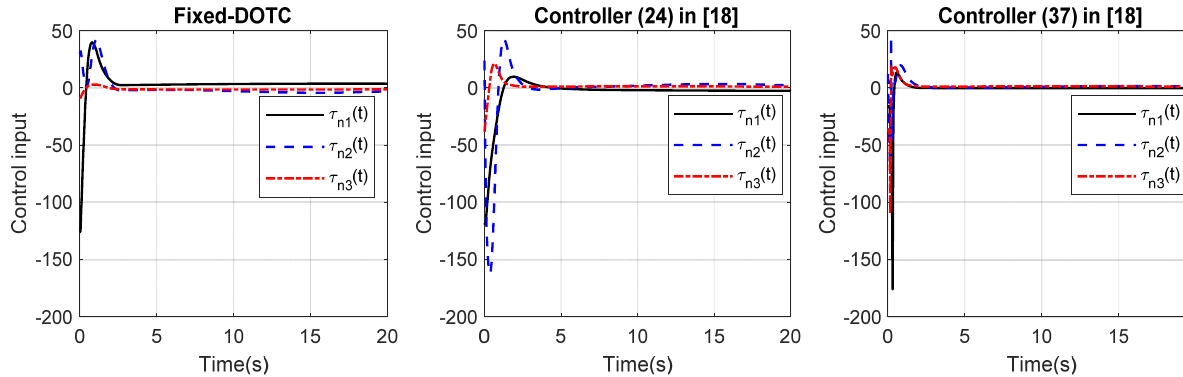
Figure 8. The control input in part 1.